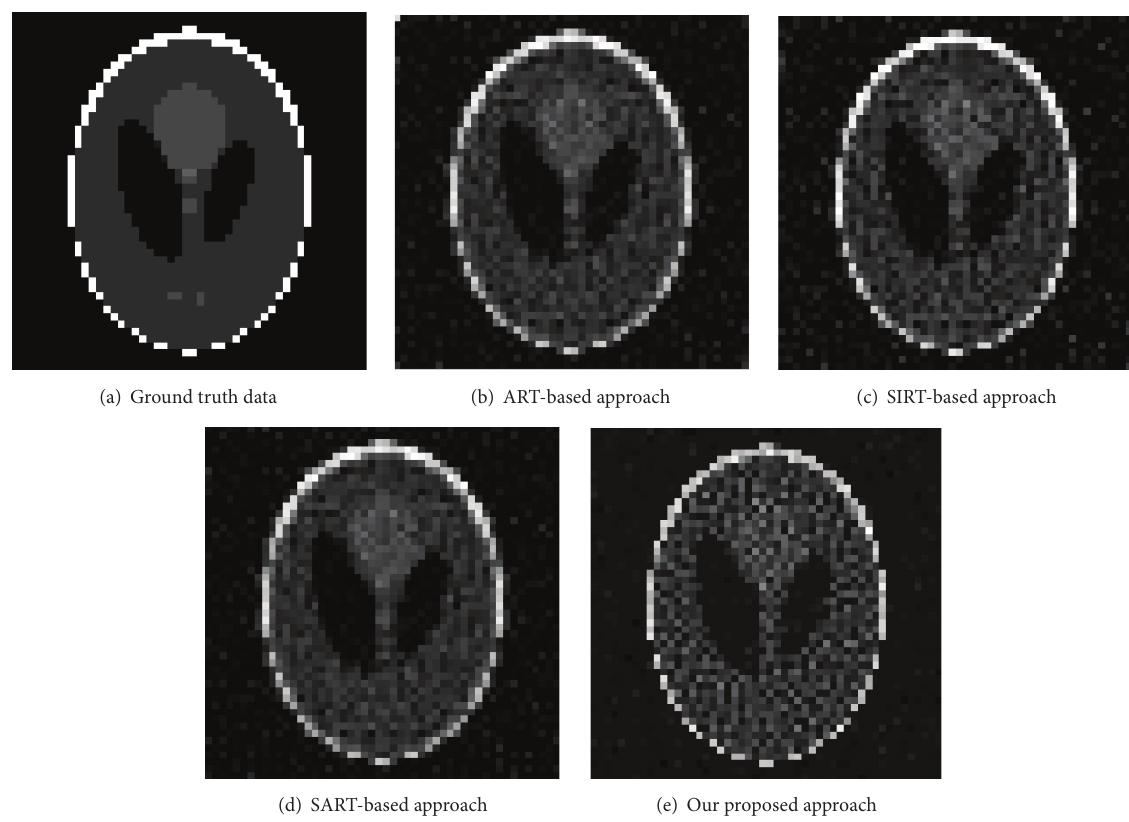
Figure 2: Comparison of image reconstruction from 2250 angular projections around the target